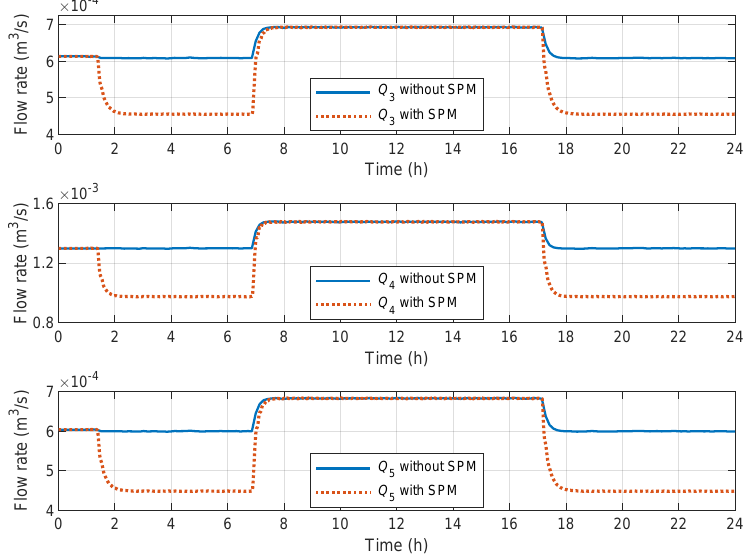
Figure 11. Case 3: Flows in the main water intakes for the